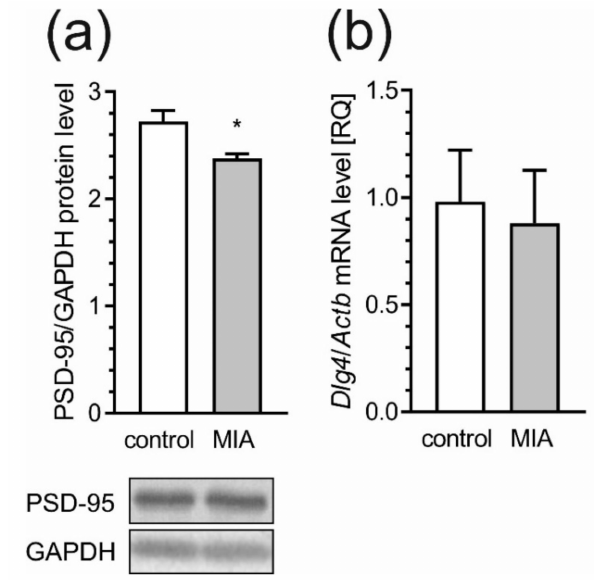
Figure 11. MIA evokes decrease of PSD-95 in o ff spring rats. The e ff ects of prenatal MIA exposure on post-synaptic protein 95 (PSD-95) were analyzed in cerebral cortex of PND 53–54 o ff spring rats. ( a ) Immunoreactivity of PSD-95 protein and GAPDH were analyzed by SDS-PAGE and Western blot. Representative Western blots are presented. Results of densitometric analysis of the investigated protein are presented as the mean value ± S.E.M. ( b ) The mRNA level of PSD-95 gene, Dlg4, was determined using real time PCR and normalized to Actb ( β -actin). Data represent the mean value ± S.E.M. (a–n = 8, b–n = 3–5). Data were analyzed using Student’s t -test. * p < 0.05 as compared to control